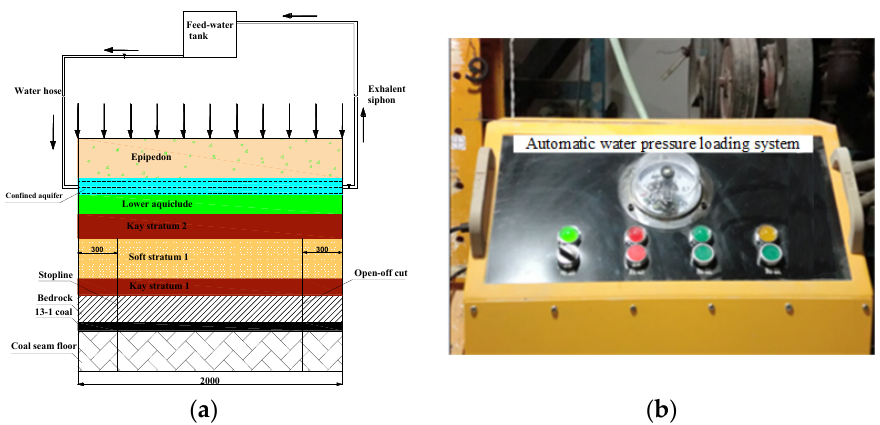
Figure 2. Physical model. ( a ) Water sand belt simulation diagram. ( b ) Water pressure balance system.